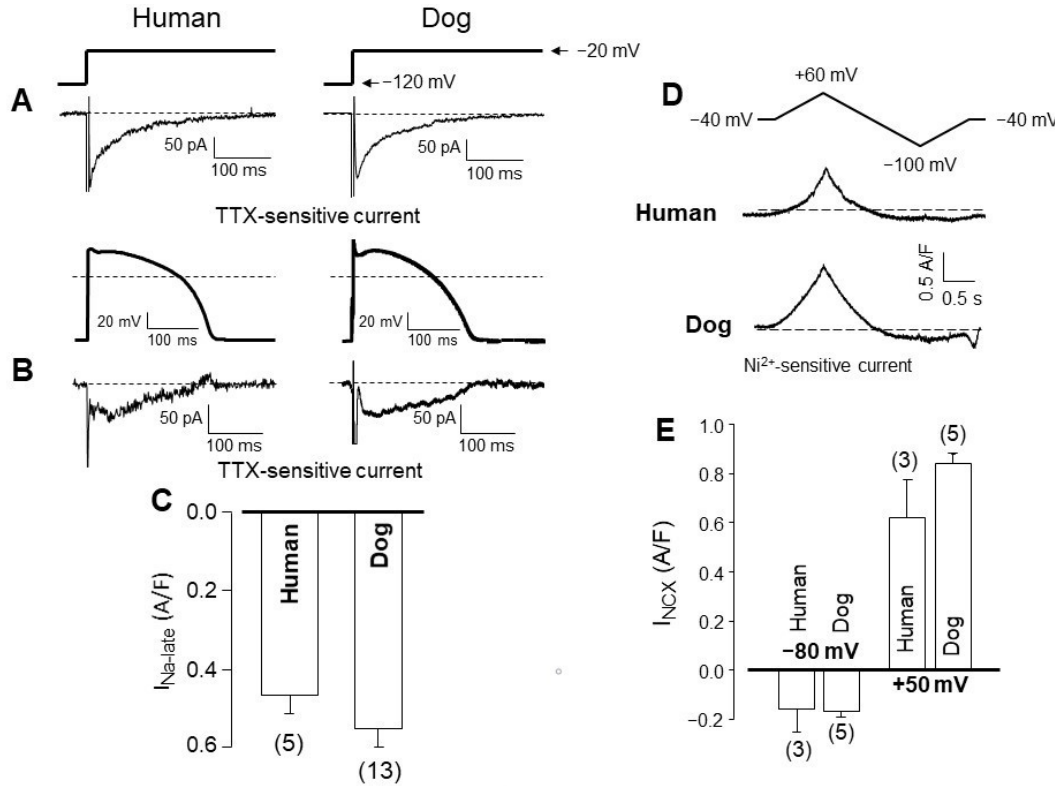
Figure 4. ( A – C ) Late Na + current (I Na-late ) in human and canine ventricular myocytes. I Na-late was recorded under conventional voltage clamp ( A ) and action potential voltage clamp conditions ( B ). The current in this latter case was excised by 10 µ M TTX. Pulse protocols are shown above. ( C ) Peak densities of I Na-late measured with action potential voltage clamp in human and canine myocytes. ( D ) Representative I NCX , defined as a 10 mM Ni 2+ -sensitive current, recorded using a voltage ramp ( − 40 mV -> + 60mV -> − 100 mV -> − 40 mV). ( E ) Peak inward (measured at − 80 mV) and outward (measured at +50 mV) NCX current densities. Columns and bars are mean ± SEM values, ( n ) denotes the number of myocytes studied. (Data from references